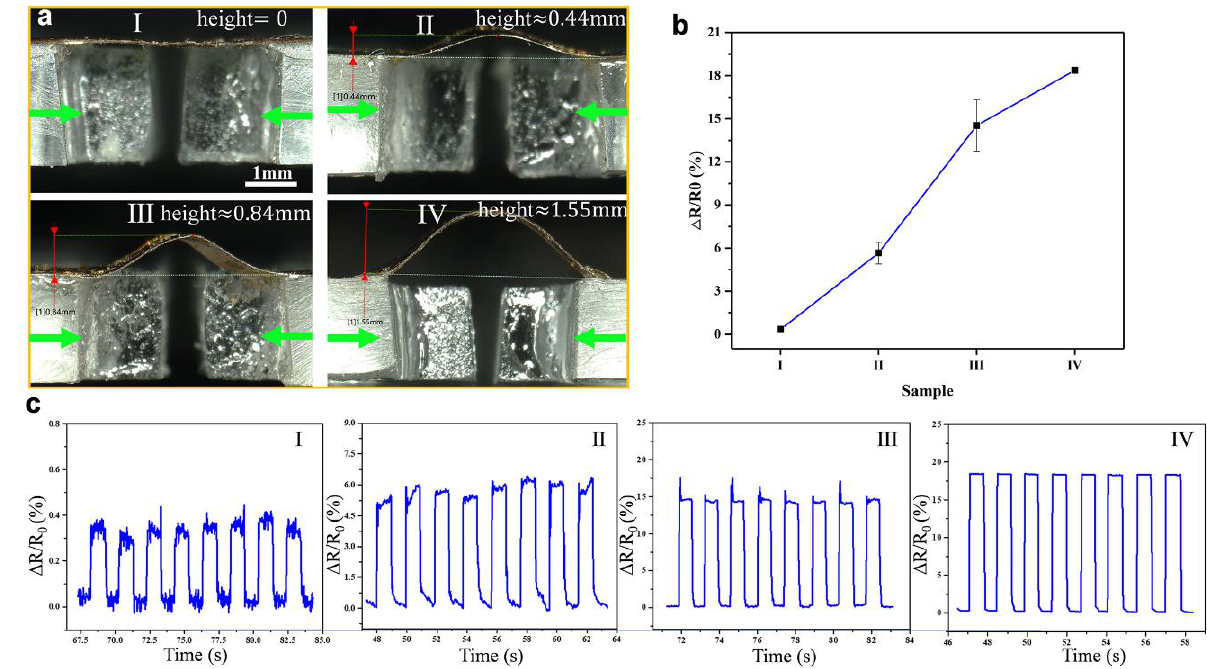
Figure 9. The influence of the initial bending degree of FUCMSS on the sensitivity of slit-based mechano-sensor. ( a ) The initial bending degree of FUCMSS covering slit wake, the direction of the green arrow represents the direction in which the load is applied. ( b ) The resistance response of the four samples in ( a ) in response to the same mechanical stimuli. ( c ) The dynamic signal-recognition capability of the four samples in ( a ).